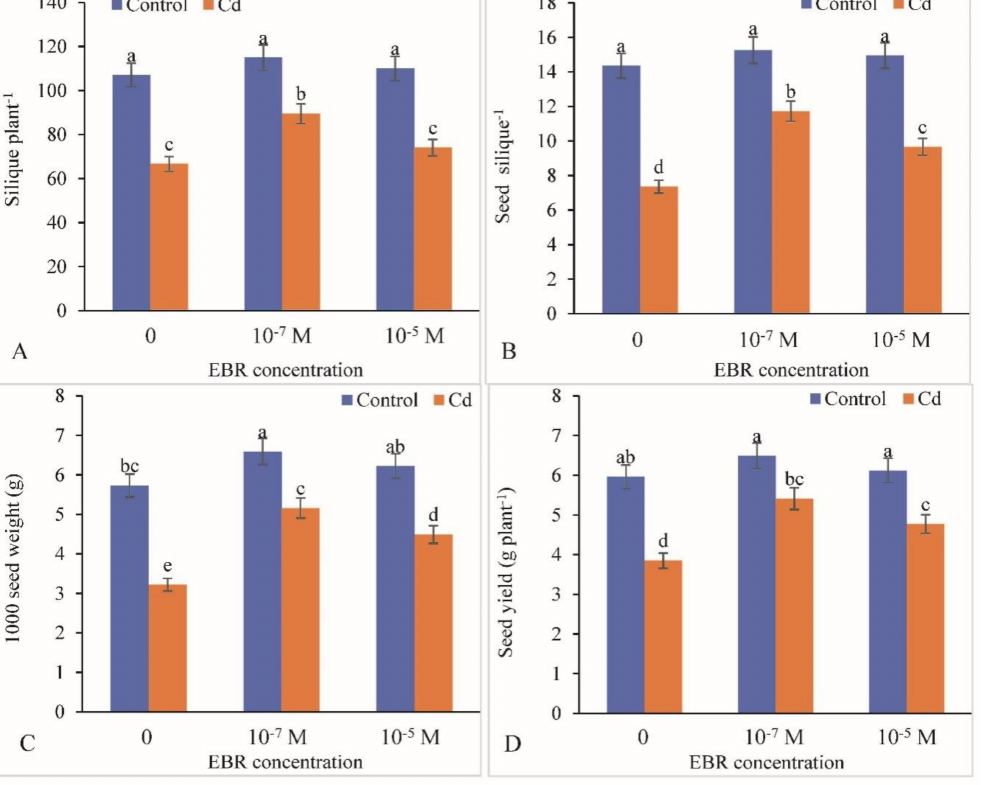
Figure 9. Foliar application of 24-Epibrassinolide enhanced the yield attributes of ( A ) siliques plant − 1 , ( B ) seed silique − 1 ( C ) 1000 seed weight and ( D ) seed yield in B. juncea under Cd (200 µ M) stress. Values with di ff erent letters above the bars are significantly di ff erent at each measured time point ( p < 0.05). (Mean ±